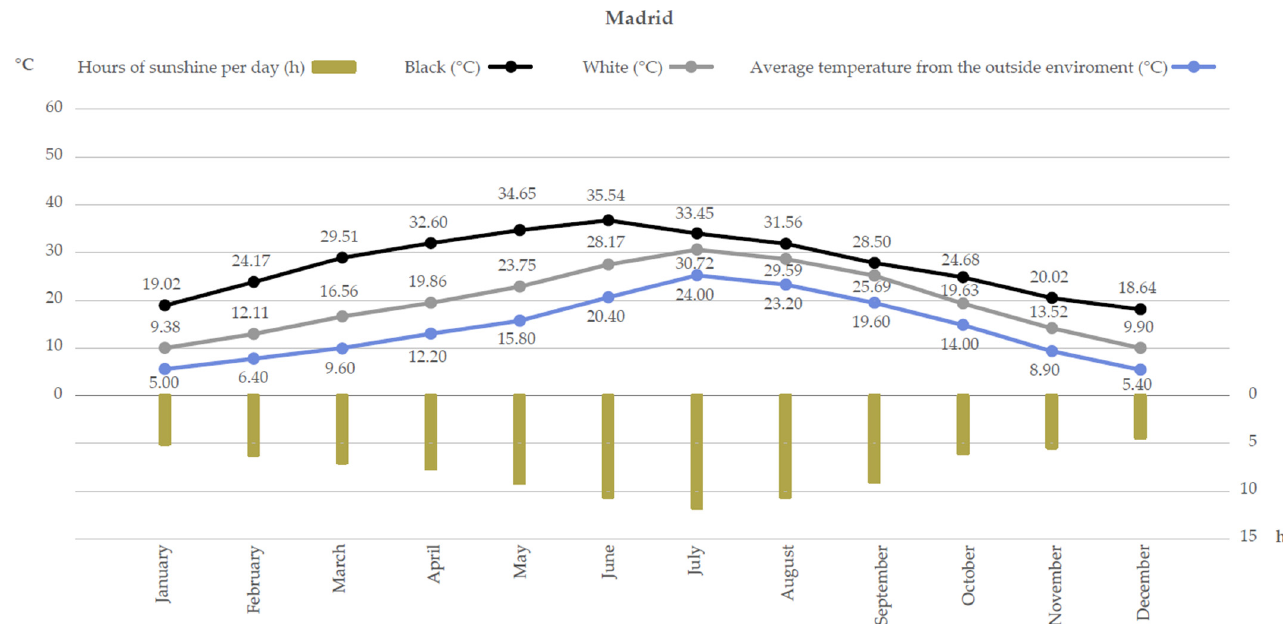
Figure 2. Surface temperatures of black and white roofs in Madrid and the average monthly temperature [42].